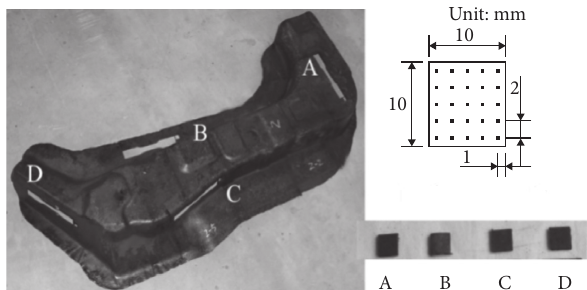
Figure 13: The formed part and samples for microstructure and hardness